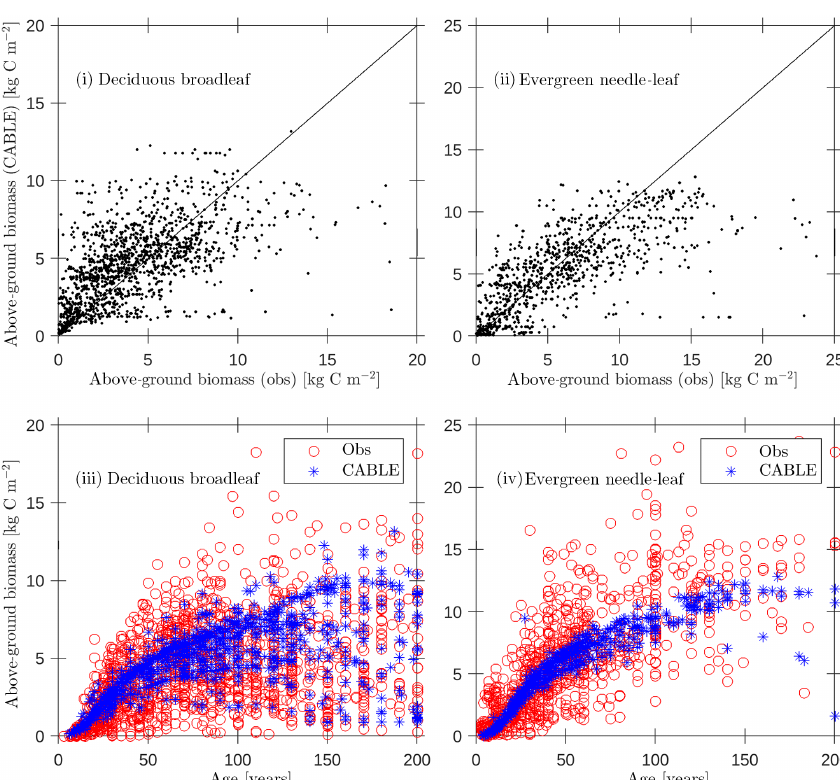
Figure 4. Evaluation of CABLE (1990) above-ground biomass predictions against biomass compartments data (Teobaldelli, 2008; Teobaldelli et al., 2009) separated into deciduous broadleaf and evergreen needle-leaf classes: (i, ii) above-ground biomass predictions versus observations (solid line represents 1:1 line); (iii) – (iv) predictions and observations of above-ground biomass versus